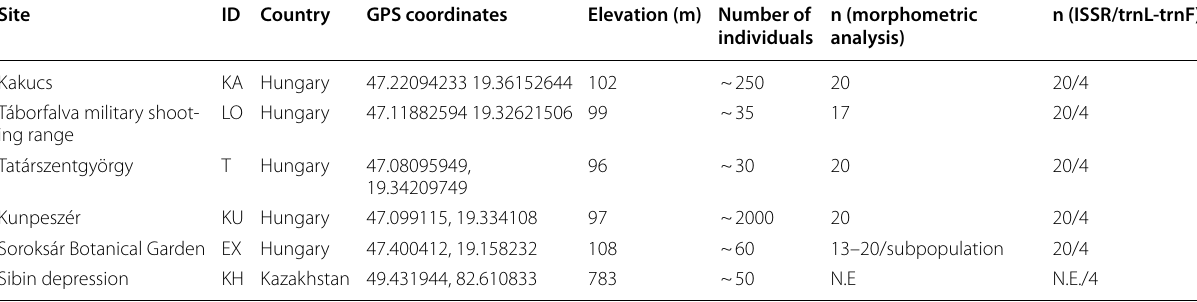
Table 1 Locations and information of the sampled Plantago maxima populations Site